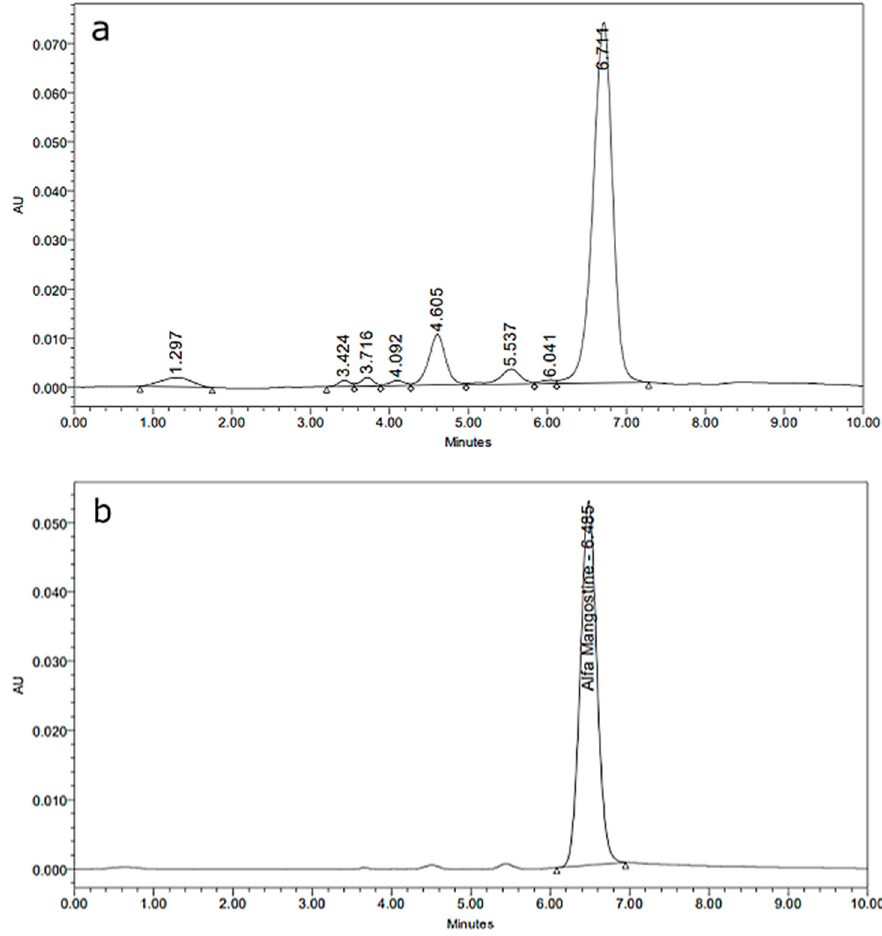
Antioxidants 2022 , 11 , x FOR PEER REVIEW Figure 1. Chromatogram of mangosteen peel extract ( a ) and standard α -mangosteen ( b ).